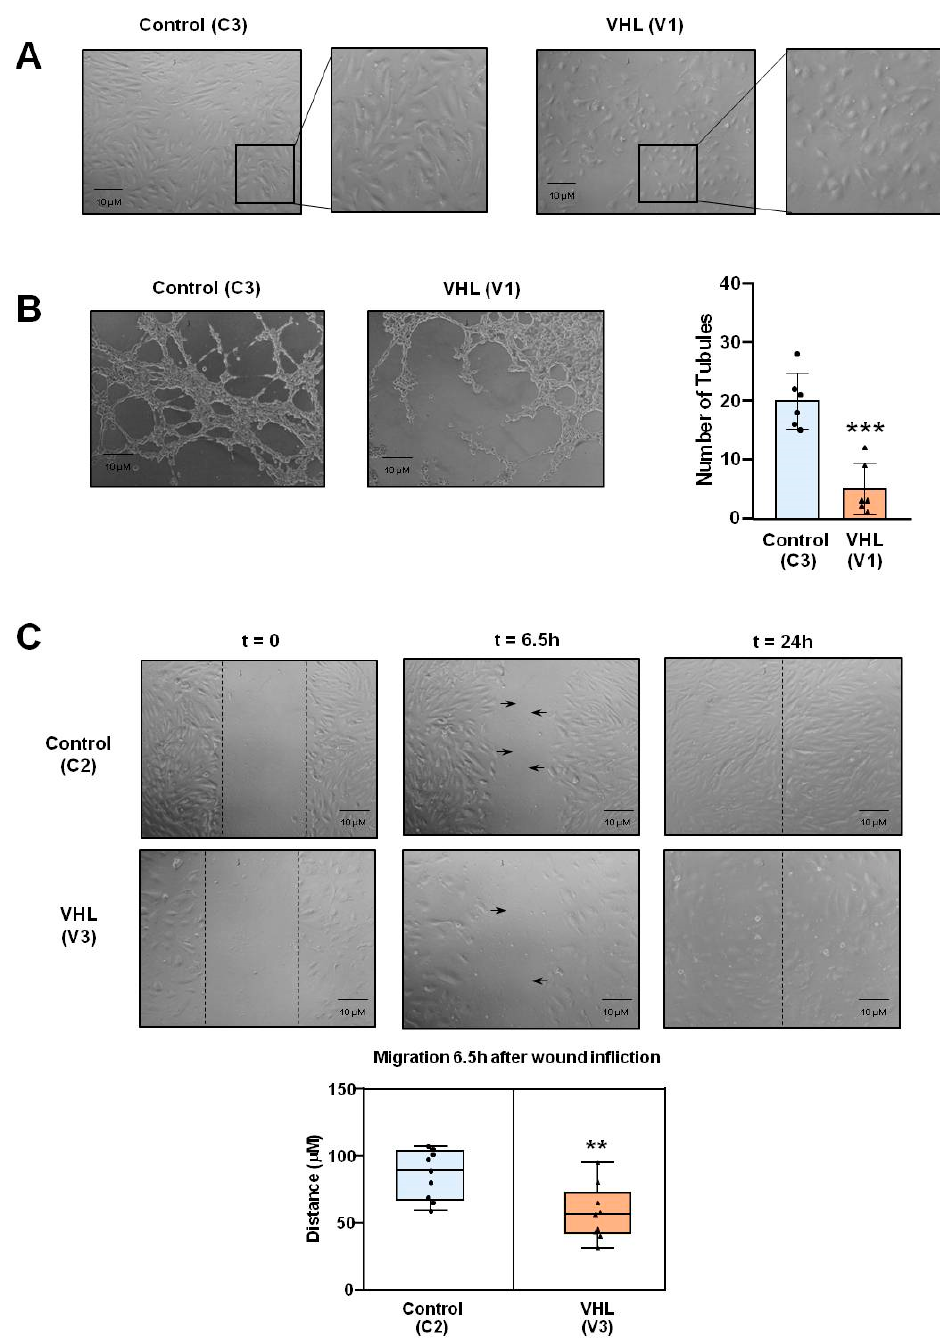
Figure 5. Morphological and functional differences between ECs derived from either healthy subjects or VHL patients. ( A ) Control and VHL ECs photographed under the microscope once confluence levels were reached. ( B ) Tubulogenesis assay performed on ECs from control vs. VHL groups, photographed 3 h after cell seeding on Matrigel-matrix-coated wells. ( C ) Wound healing assay performed on ECs from control vs. VHL groups, photographed 6.5 h after wound infliction on confluent wells. Error bars denote ±SEM. Student’s t -test: ** p < 0.01; and *** p < 0.001.